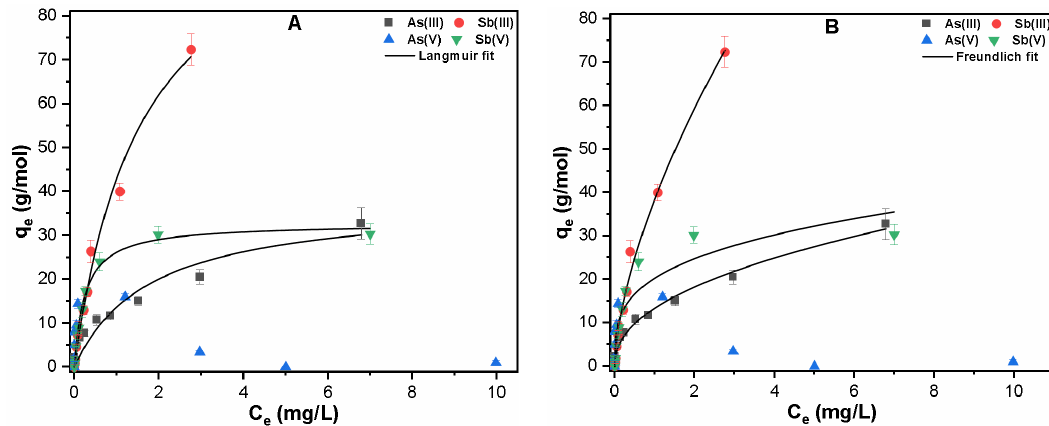
Figure 4. Under the initial As and Sb concentrations of (0.1 to 10) mg/L, pH: 7 and 0.1 mM FC dose, showing ( A ) Langmuir; and ( B ) Freundlich fitting of the As and Sb coagulation data for the single solute system. Table 1. Adsorption isotherm parameters of As(III) and Sb(III, V) on FC precipitates in the single solute system.